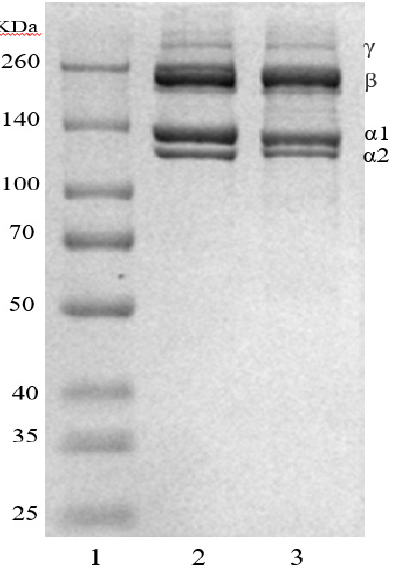
Figure 1. SDS-PAGE pattern of SCSC. (1) Marker; (2) rat tail collagen; (3)